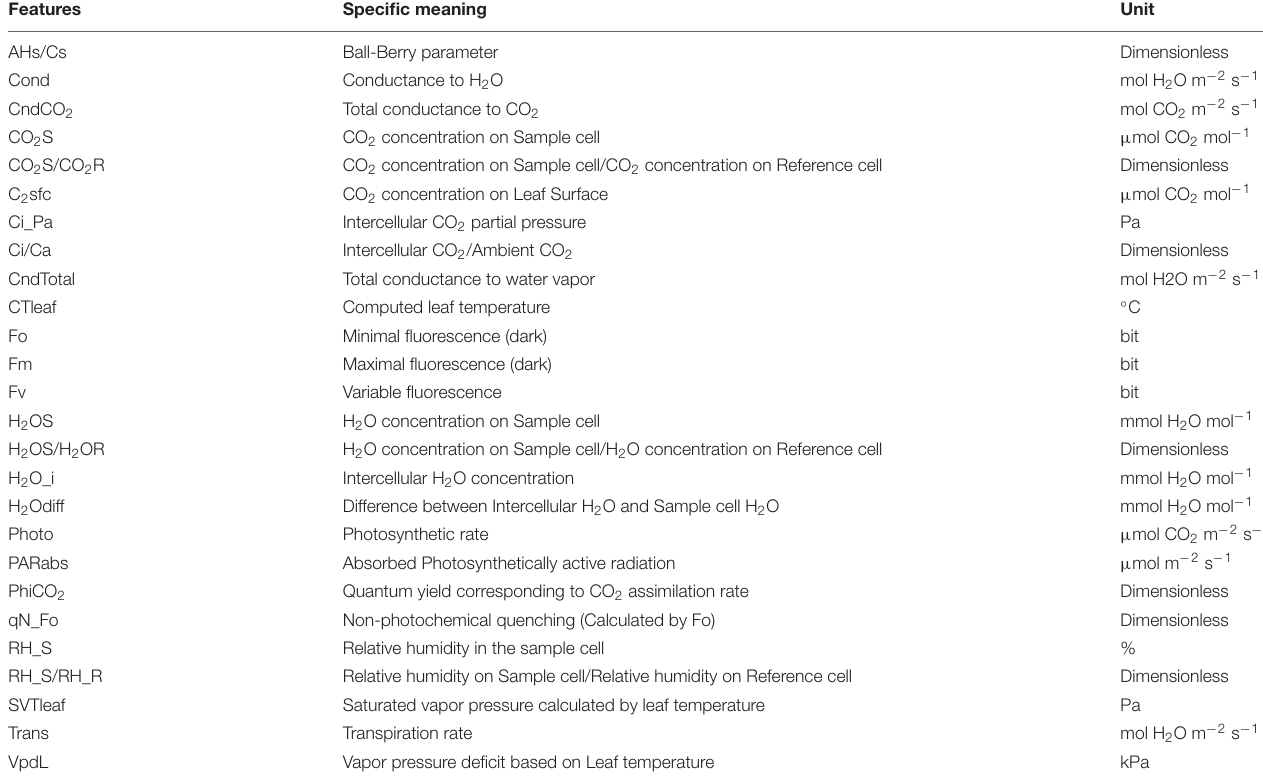
TABLE A1 | The specific meanings and correlation coefficients of 26 features.